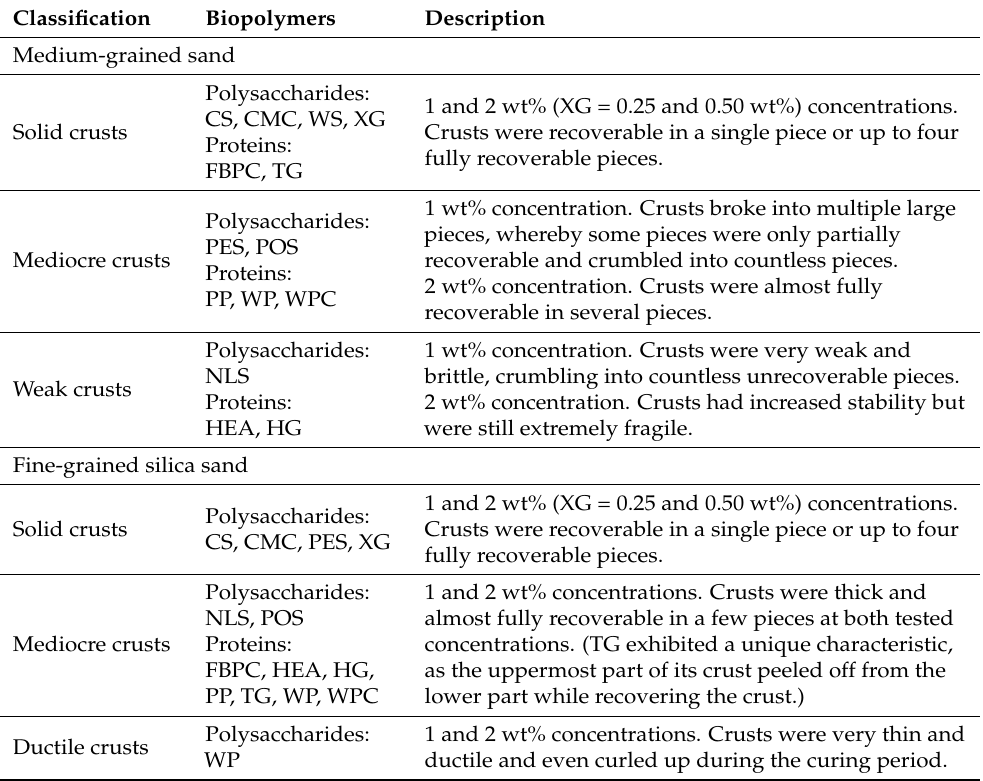
Table A6. Qualitative classification of biopolymers according to their crust’s visual appearance (cf. Figures 10 and